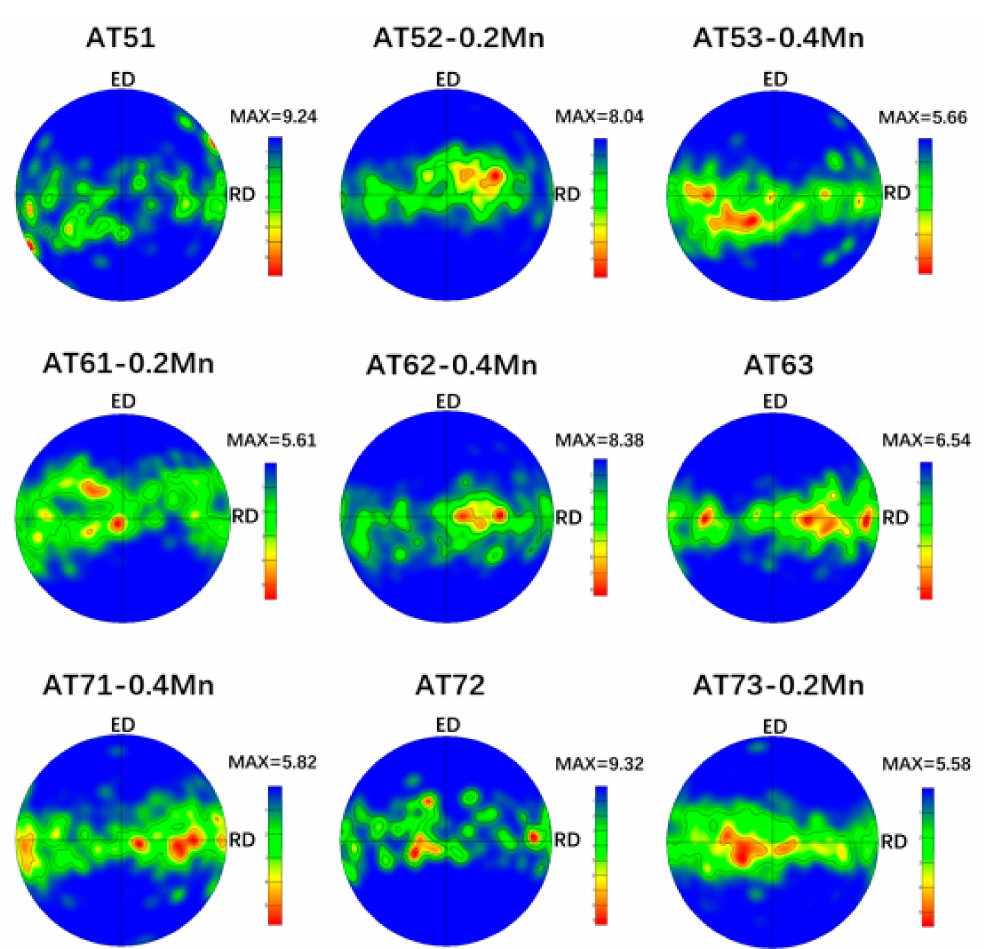
Figure 8. (0001) pole figures of extruded Mg-Al-Sn-Mn magnesium